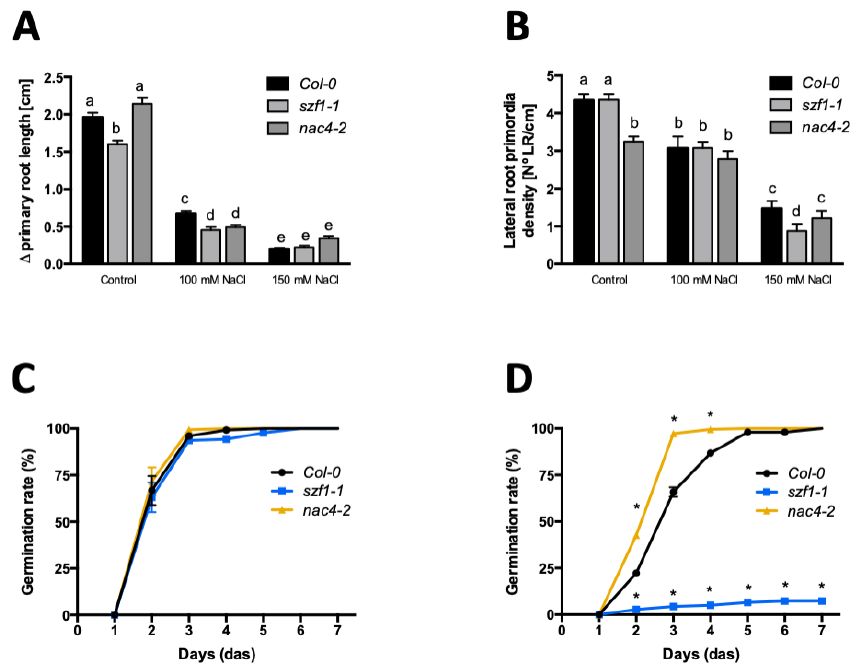
Figure 5. nac4-2 and szf1-1 mutant lines show an altered response to salt stress in Arabidopsis thaliana . ( A , B ) 3-day-old Col-0 WT, nac4-2, and szf1-1 lines were transferred to MS medium supplemented with 0, 100, or 150 mM of NaCl for five days. Primary root growth under NaCl treatment ( A ) and lateral root primordia density ( B ) were quantified. ( C , D ) Germination rates of Col-0 WT, nac4-1, and szf1-1 plants were determined on MS medium ( C ) and the same medium supplemented with 150 mM of NaCl ( D ). ANOVA and Bonferroni a posteriori tests were performed. *: p < 0.05. a, b, c, d represents statistically significant di ff erences with p < 0.05. Error bars represent the standard error of the mean. Each experiment was performed in triplicates with at least 12 seedlings ( A , B ) or 100 seeds ( C , D ) per